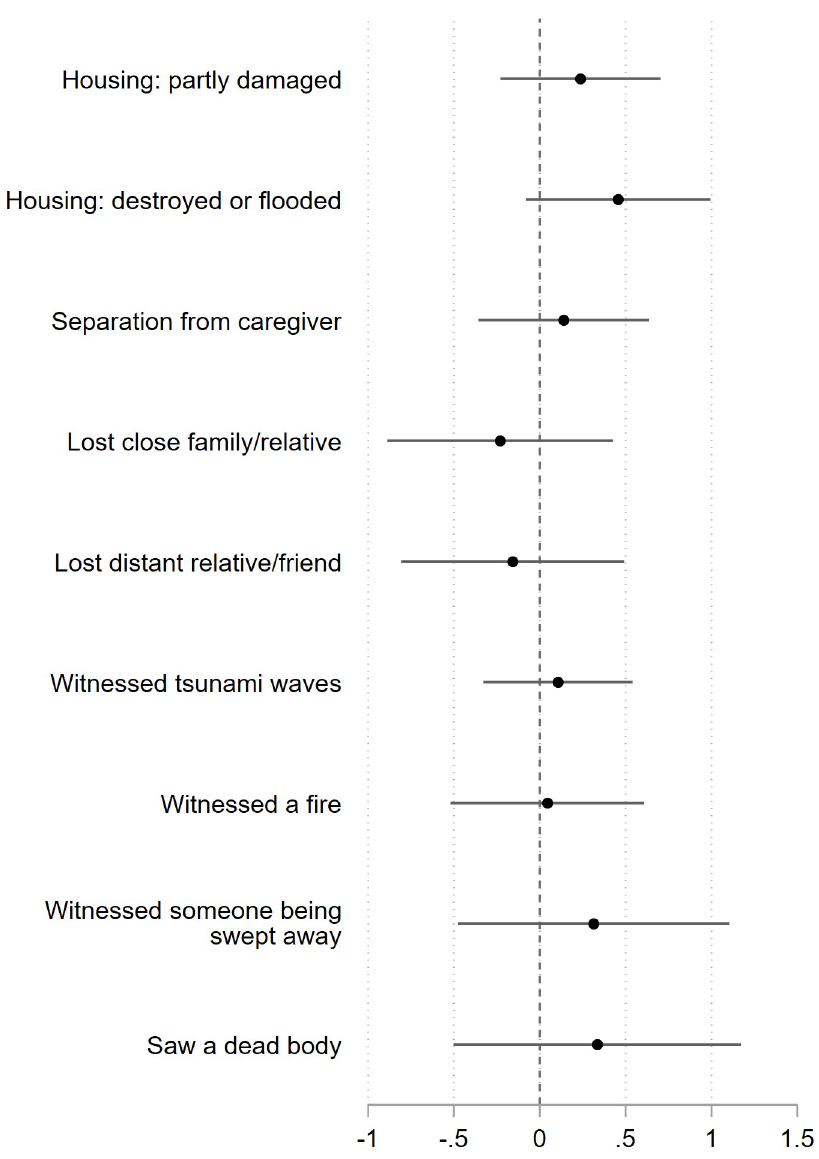
Fig 3. Association between traumatic experiences and delay discounting adjusted for child’s age, sex, maternal education, household subjective economic status before the disaster, and household income at the follow − up survey. Missing values were included as dummy variables, but estimates were not reported; every traumatic experience was separately included (i.e., not mutually adjusted